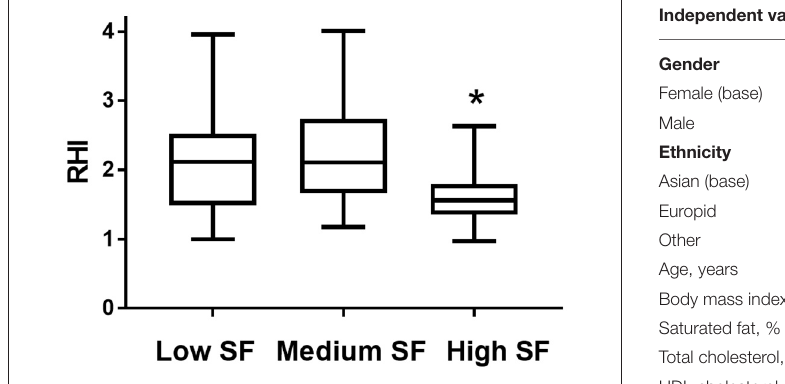
FIGURE 1 | Reactive Hyperaemia index (RHI) in individuals with habitual consumption of saturated fat (percentage of saturated fat/total fat) in the lowest tertile (Low SF), second tertile (Medium SF), and highest tertile (high SF). Data is presented as mean with minimum and maximum values. *Indicates P < 0.01 High SF vs. Low SF and High SF vs. Medium SF.